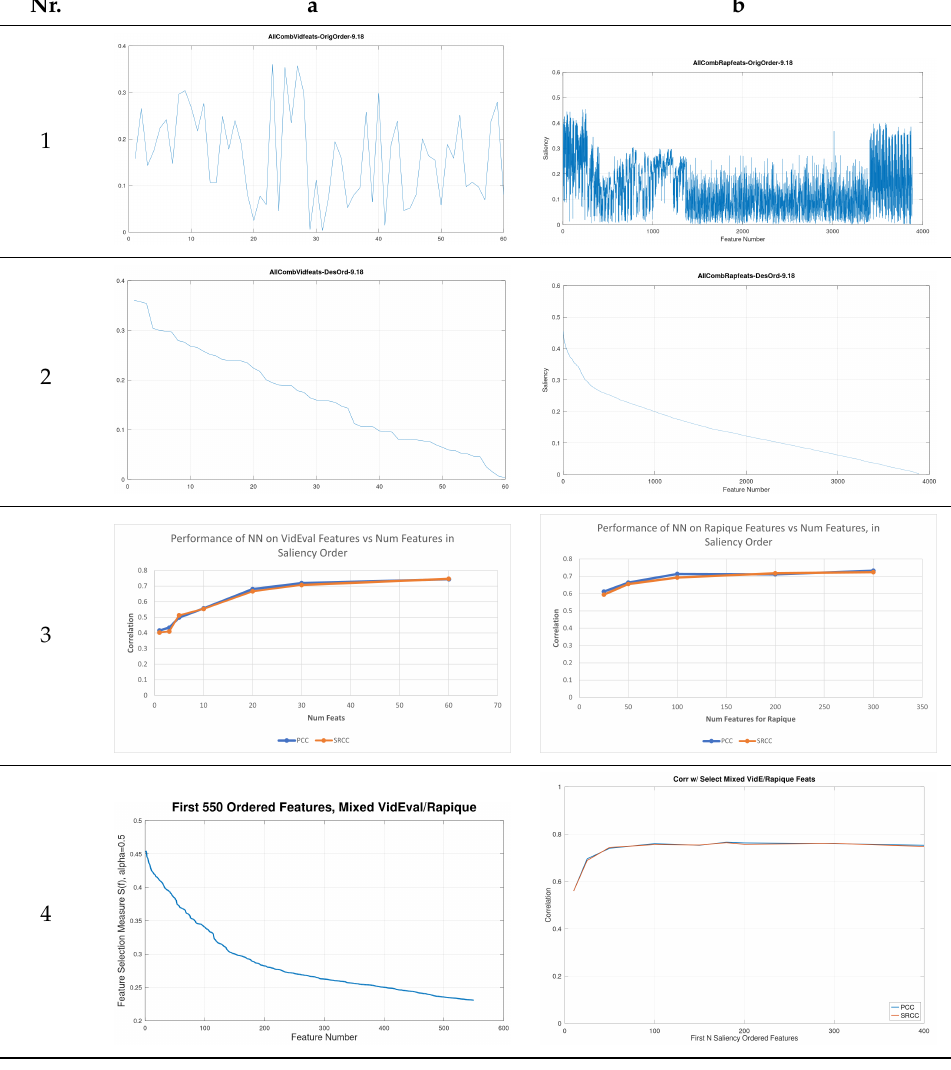
Table 3. Row 1: Features from (a) VIDEVAL and (b) RAPIQUE, for the AllCombined NR dataset, in original order. Row 2: Same features in descending Saliency order. Row 3: Prediction performance under a FastVDO parameter-free neural network regressor, over 50 runs, using the first N Saliency- ordered features. Row 4: Saliency ordering of mixed VIDEVAL/RAPIQUE features, and correlation coefficients PCC and SRCC using the Saliency-ordered features. Our best results are with all 60 VIDE- VAL and the top 120 RAPIQUE features, reported in the last row of Figure 4. While our approach did not achieve state-of-the-art performance, we did clarify that just a few of the most salient features from each algorithm provided most of the predictive performance.